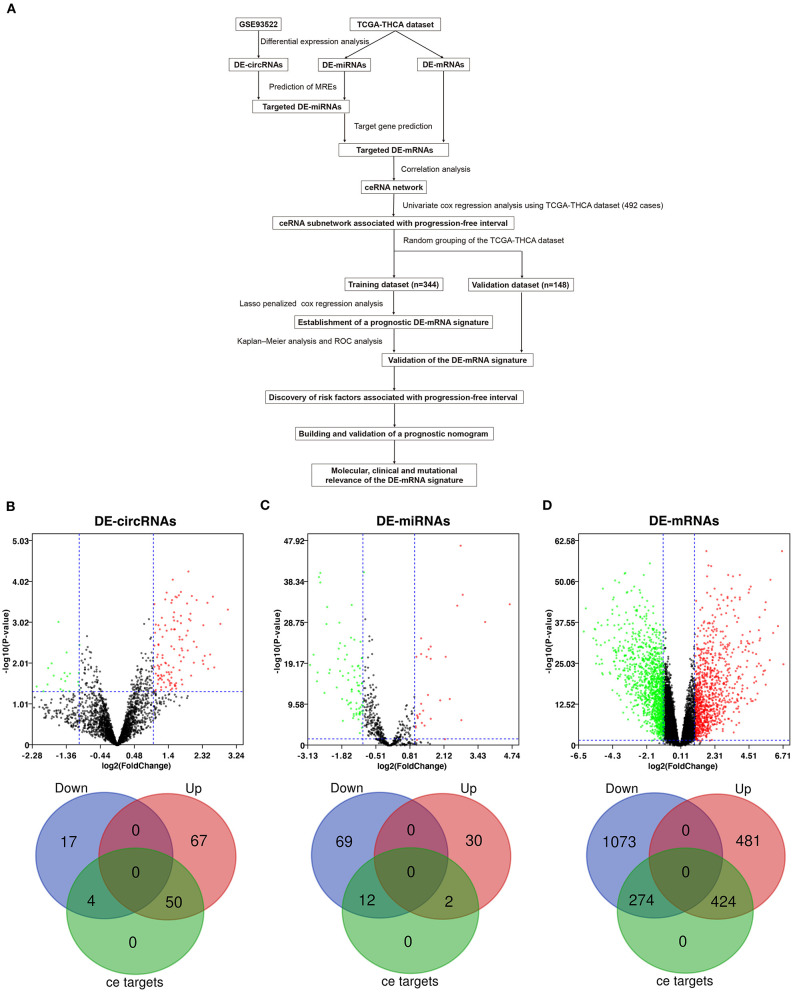
Differential expression analysis and prediction of potential circRNA-associated competing endogenous RNA (ceRNA) regulatory relationships. (A) The workflow of constructing a circRNA-associated ceRNA network and the establishment of novel prognostic DE-mRNA signature and nomogram to predict risk of progression in post-surgical papillary thyroid carcinoma (PTC). (B) The volcano plot and the Venn diagram show that 138 differentially expressed circRNAs (DE-circRNAs) are identified in PTC (117 upregulated and 21 downregulated). Of these, 54 DE-circRNAs are associated with potential ceRNA regulatory relationships. (C) The volcano plot and the Venn diagram show that 113 differentially expressed miRNAs (DE-miRNAs) are identified in PTC (32 upregulated and 81 downregulated). Of these, 14 DE-miRNAs are associated with potential ceRNA regulatory relationships. (D) The volcano plot and the Venn diagram show that 2,252 differentially expressed mRNAs (DE-mRNAs) were identified in PTC (905 upregulated and 1,347 downregulated). Of these, 968 DE-mRNAs are associated with potential ceRNA regulatory relationships.